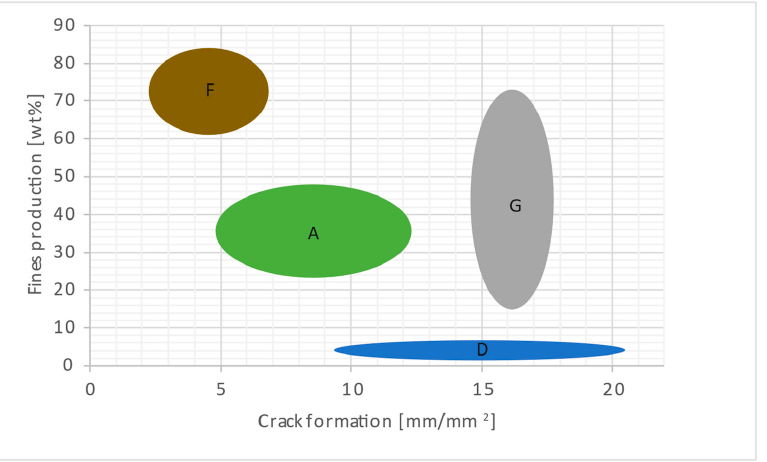
Figure 9. Crack formation at 1600°C and fines production from shock heating to 1500 °C [11] for quartz type A, D, F and G. Fines are defined as particles <10 mm. Crack formation is given in mm/mm 2 , while fines production is given in wt%.